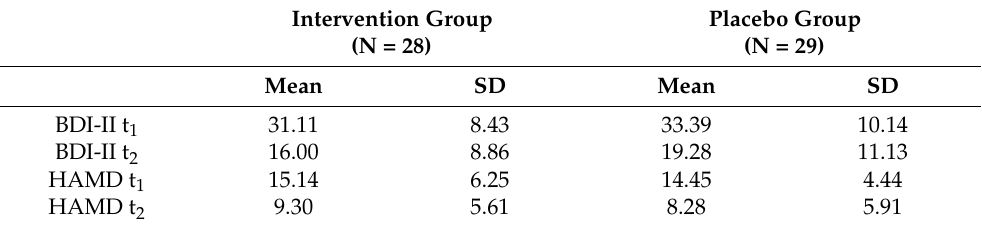
Table 3. Mean values and standard deviation of depression scores of PROVIT